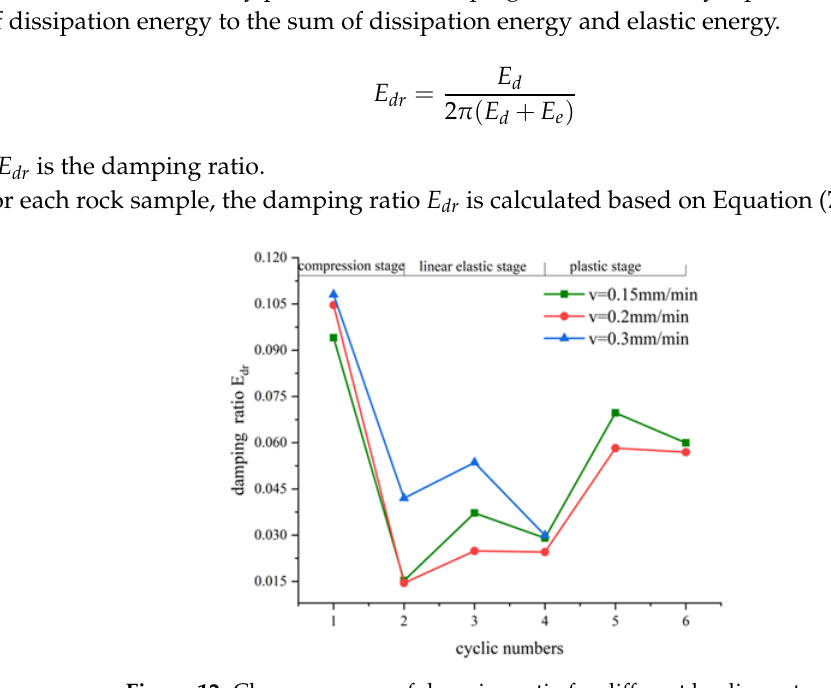
Figure 12. Change process of damping ratio for different loading rates.